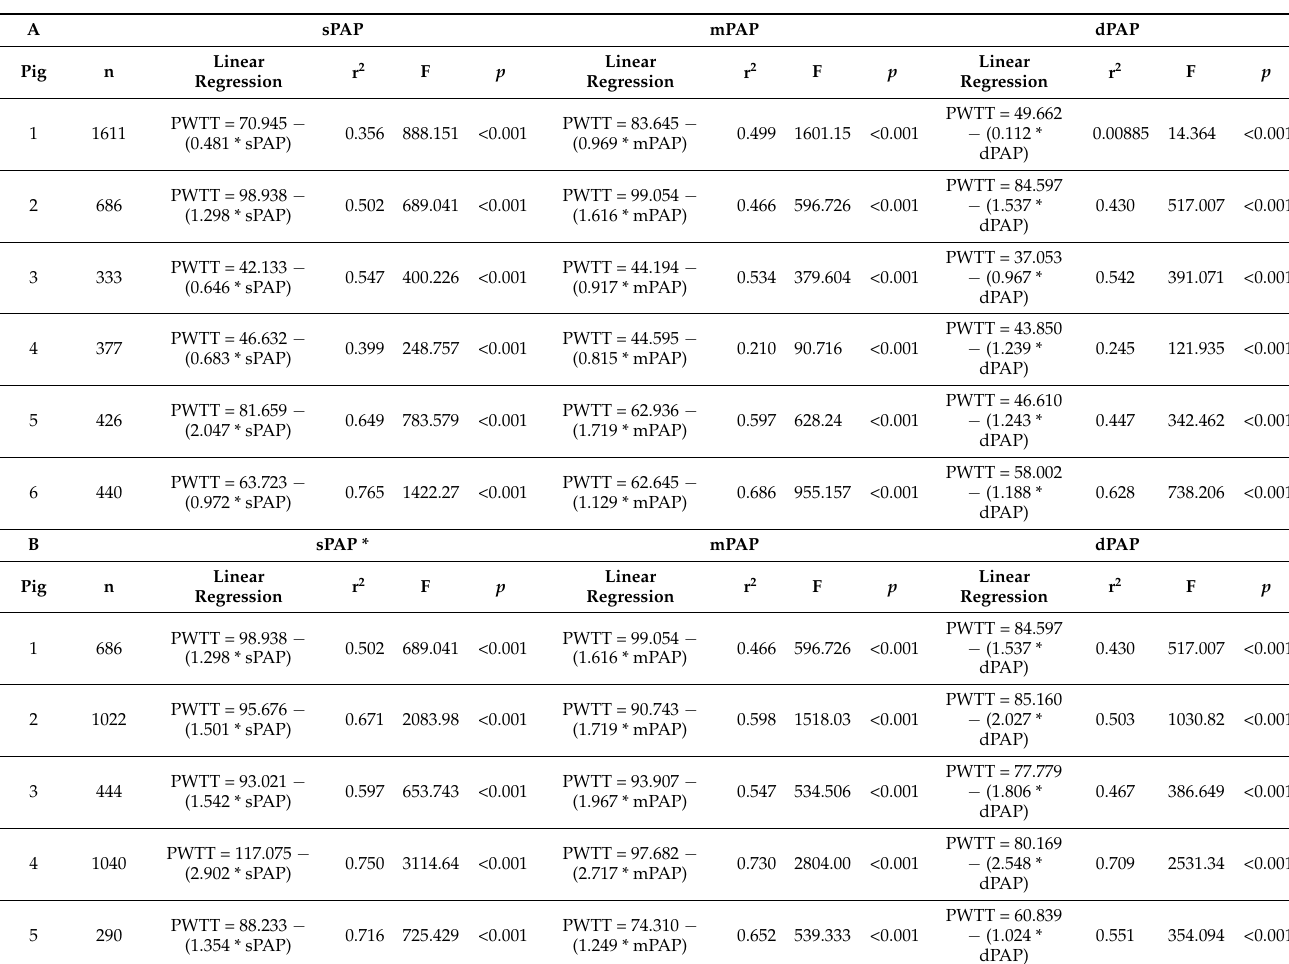
Table 3. Statistics for linear regression analysis for correlation of PWTT and sPAP, mPAP and dPAP for thromboxane A2-induced PH (A, n = 6) and hypoxic pulmonary vasoconstriction (B, n = 5). For each animal the number of consecu-tive heart beats analysed during induction of PH is given as n. Linear regression was performed using the least square method by Pearson, F-Test and p value were calculated (below). The significantly better correlation for sPAP compared to dPAP is highlighted with the asterisk (*) ( p ≤ 0.05,